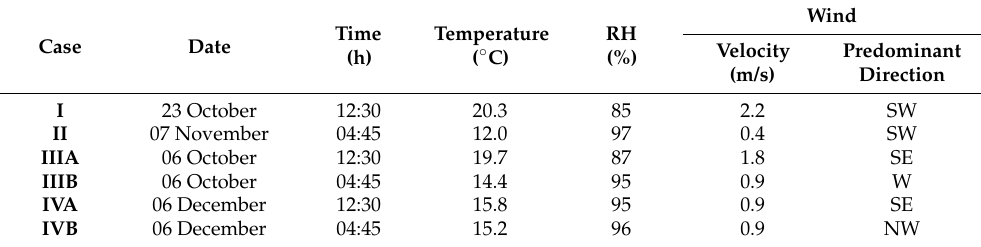
Table 2. Values of climatic variables considered in the case studies.